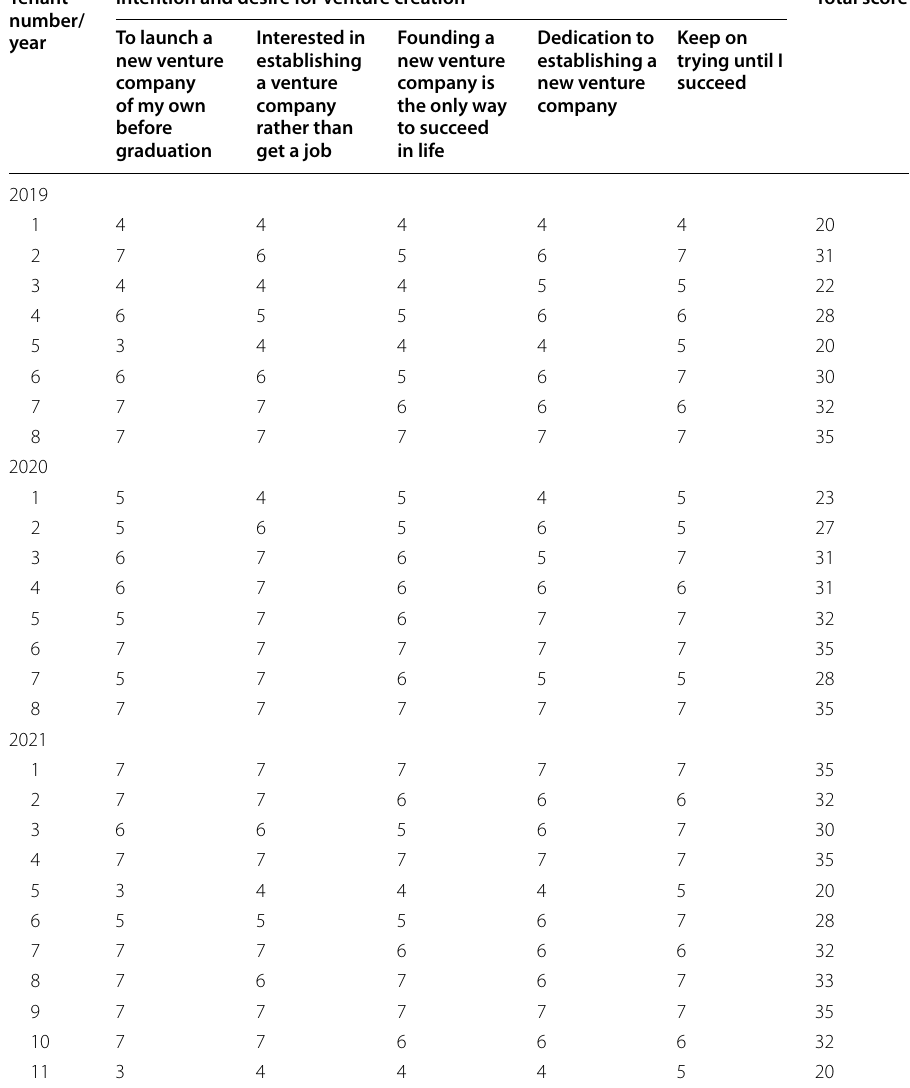
Table 4 Entrepreneurial